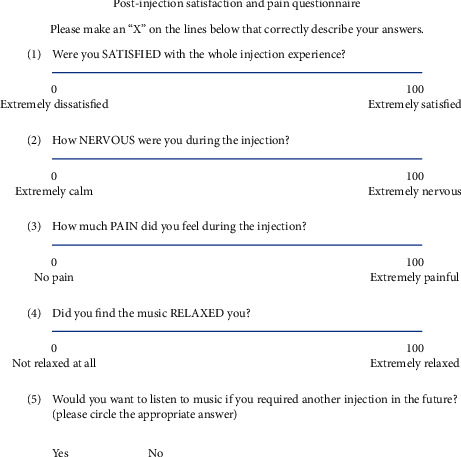
VAS questionnaire.